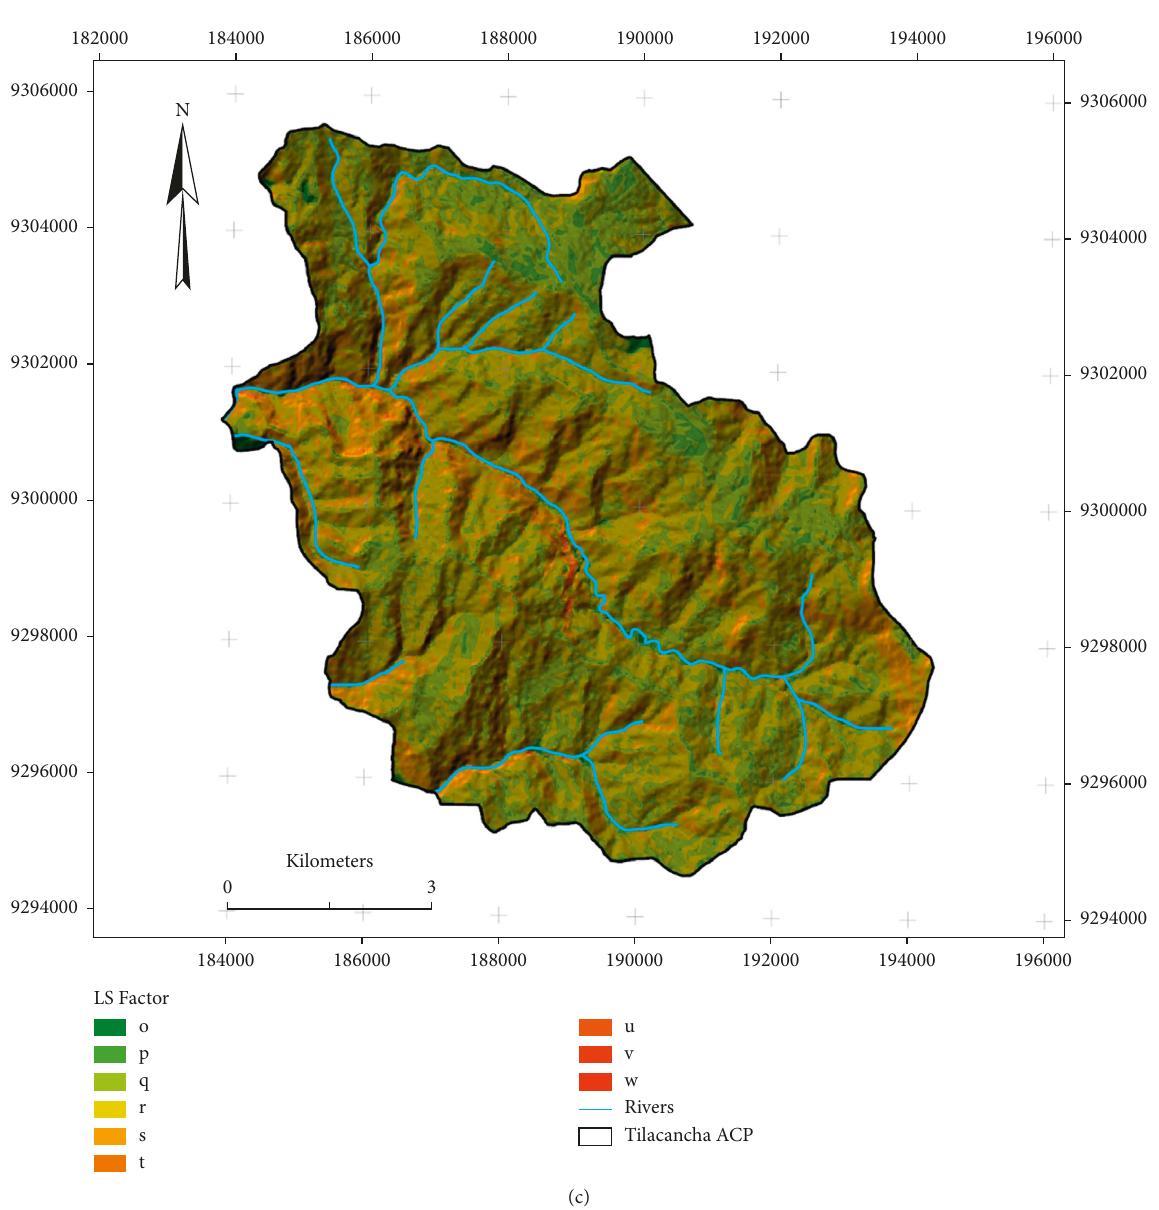
Figure 5: Land cover map for the Tilacancha ACP ( C